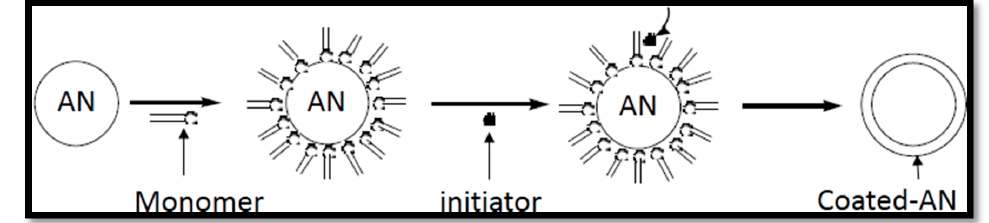
Figure 4. Monomer and polymeric particles adsorbed surface-coating schematic.